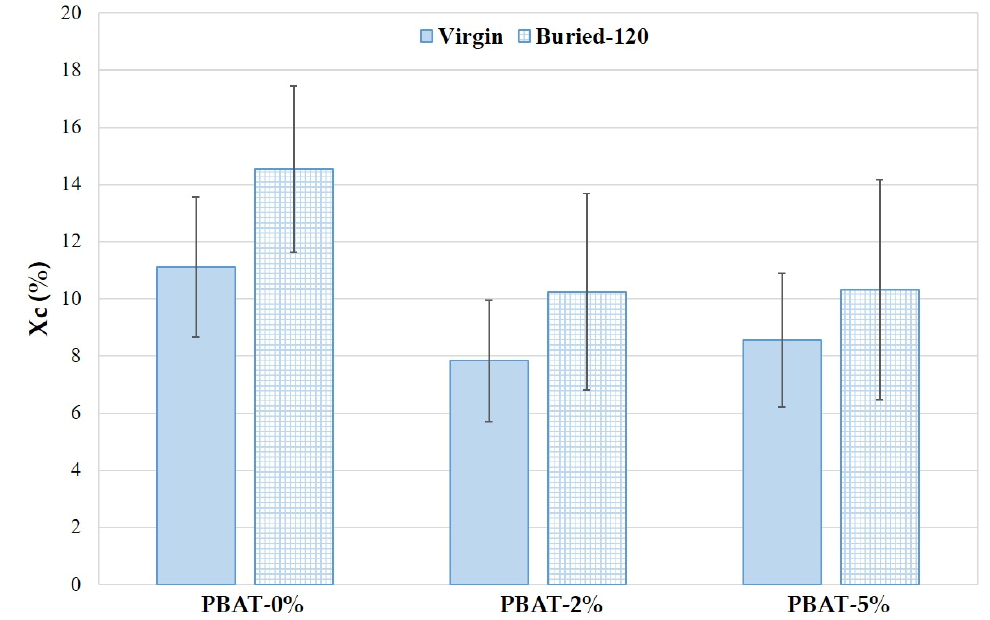
Figure 6. Crystallinity (Xc) of PBAT and nanocomposites, before and after degradation (120 days).